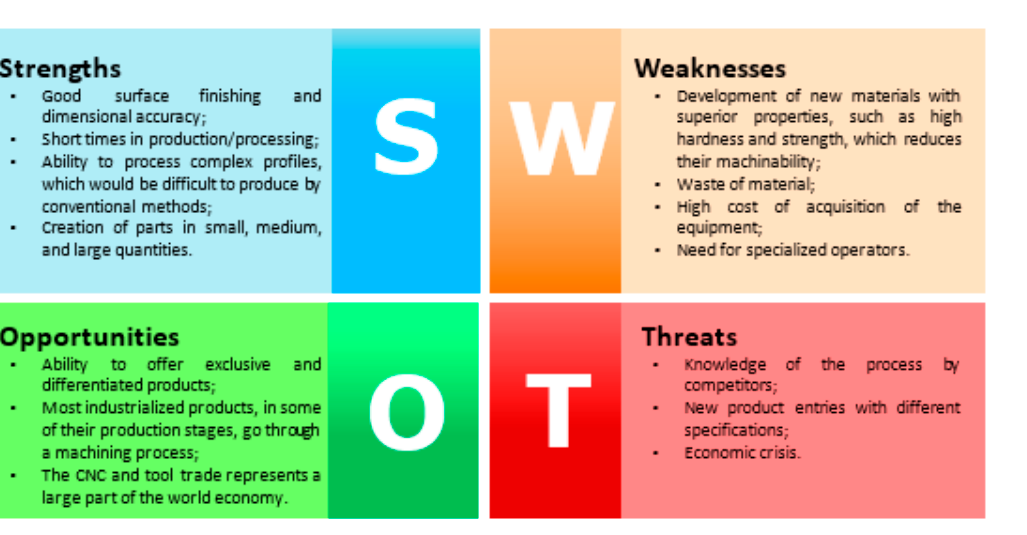
Figure 8. SWOT analysis regarding machining.